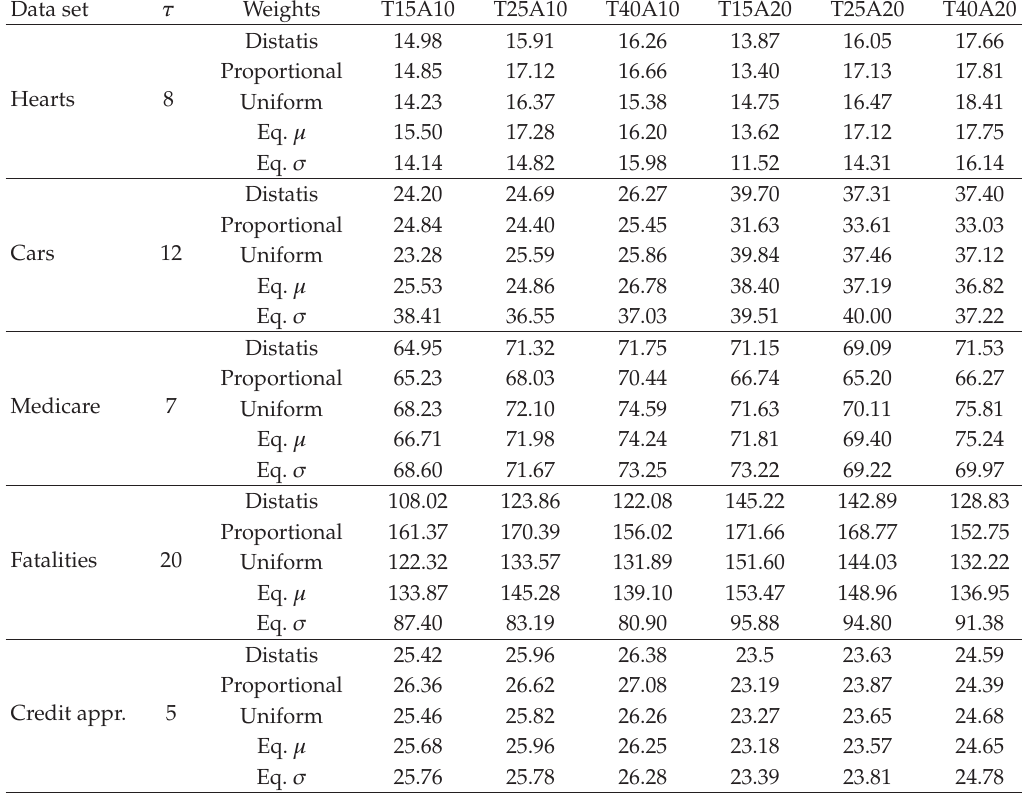
Table 1: Missing values in all the variables: mean relative